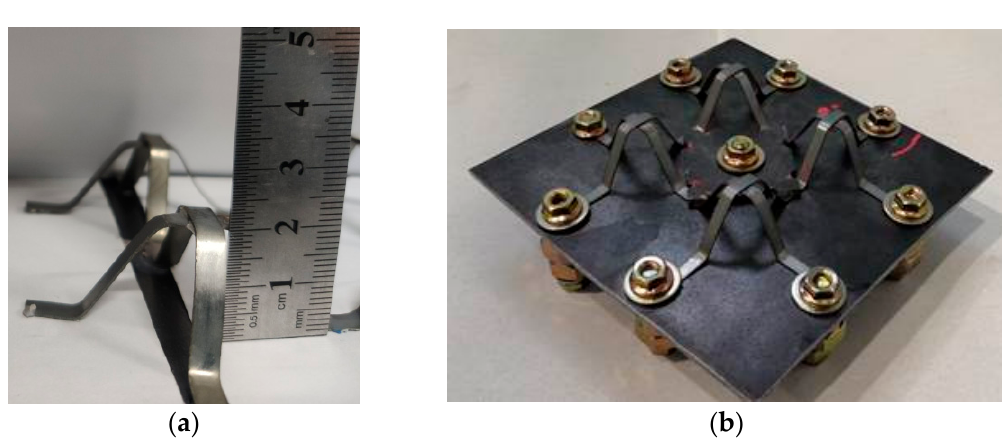
Figure 4. ( a ) The height of Monomer of NiTi SMA bracket, ( b ) NiTi SMA bracket combination module.